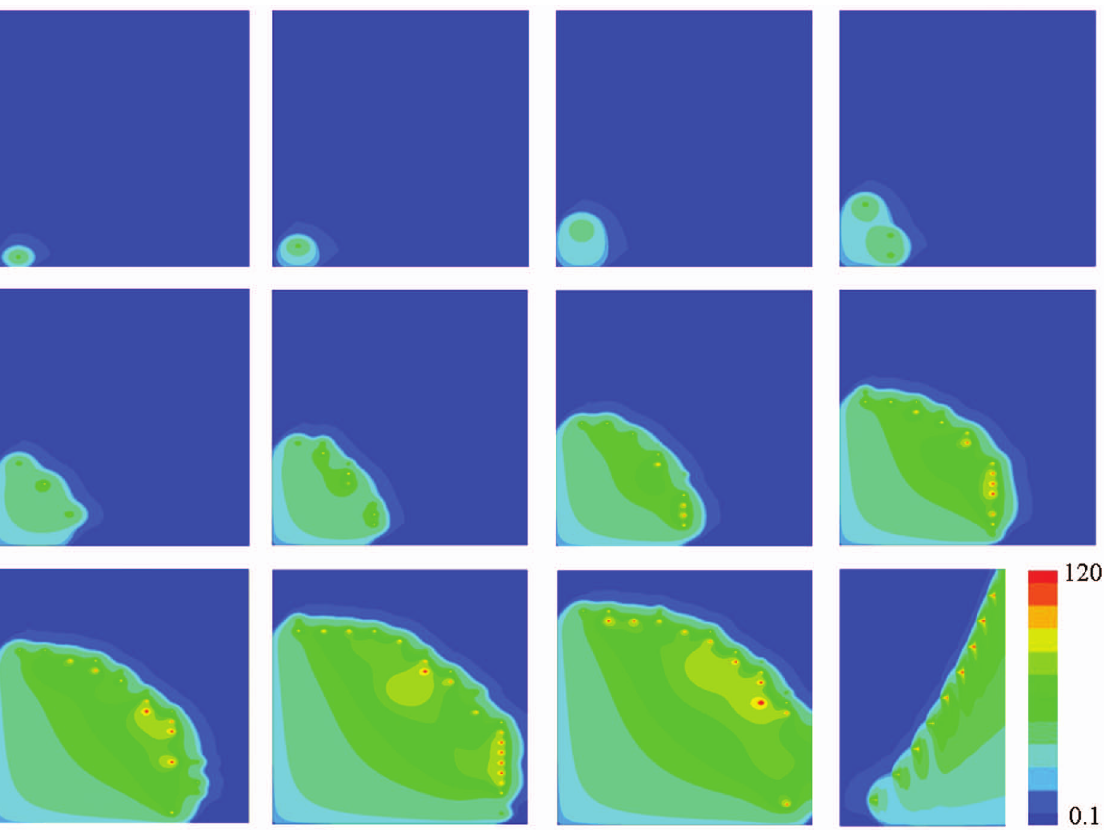
Figure 2. Snapshots of C a 2 z waves initiating from a 10ms opening of the CRU at the point (2,0.8). Snapshots are taken at 10, 30, 50, 70, 90, 110, 130, 150, 170, 190 and 200ms (left to right, top to bottom). Image 12 is the longitudinal linescan images along y ~ 2 : 4 m m . The value of parameters are b ~ 2 : 25 , I CRU ~ 5p A and l x ~ 2 : 0 m m . The concentration is from 0 : 1m M to 120m M .